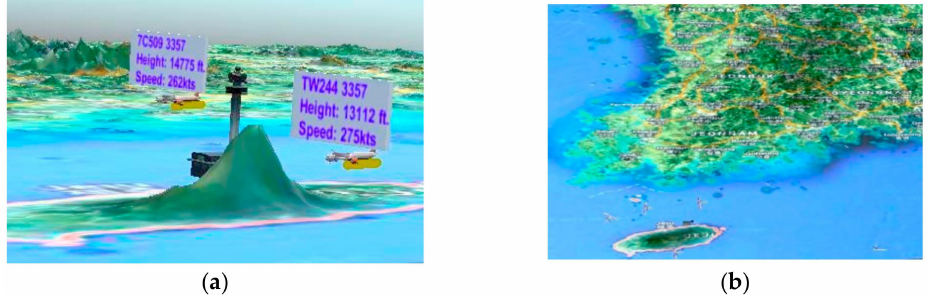
Figure 4. Map view of the airfield. In map view: ( a ) Showing a close view of the 3D height map. ( b ) Top view of the map.